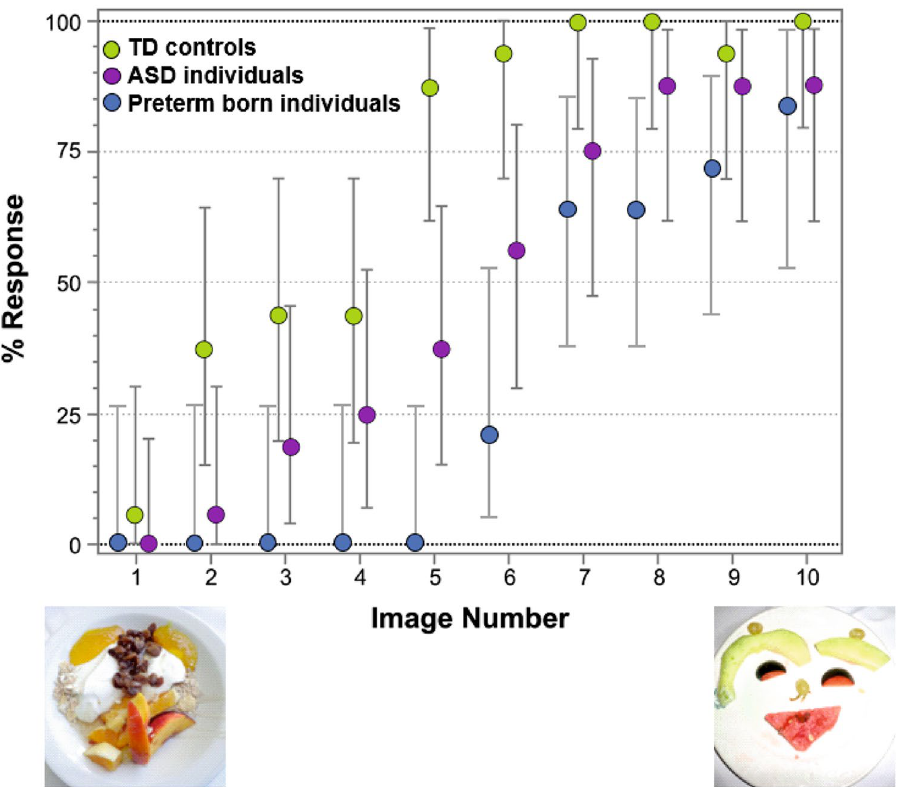
Figure 3. Percentage of face responses for each Face-n-Food image in TD controls (green), former preterms with PVL (blue), and patients with autistic spectrum disorders (ASD, violet). The image number reflects its face resemblance (1, the least recognizable as a face, through 10, the most resembling a face images from the Face-n-Food task; see Ref. 61 ; the Creative Commons Attribution [CC BY] license). Vertical bars represent 95% confidence interval, CI. The data for individuals with ASD had been reported earlier (see Ref. 64 ), and provided here for comparison